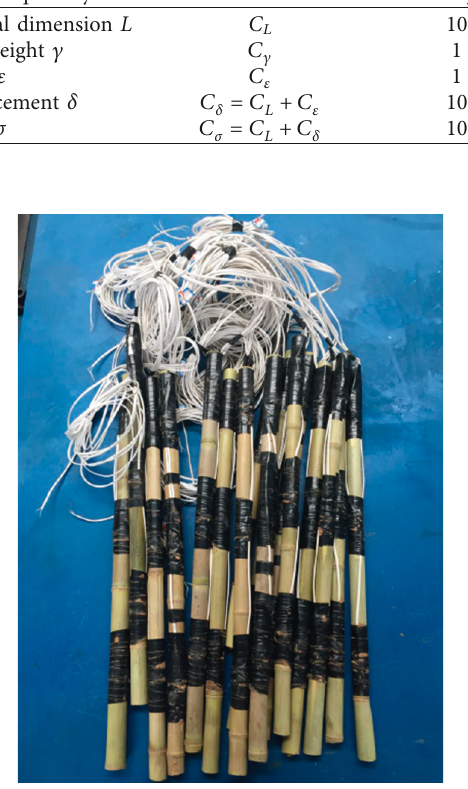
Figure 3: Bamboo